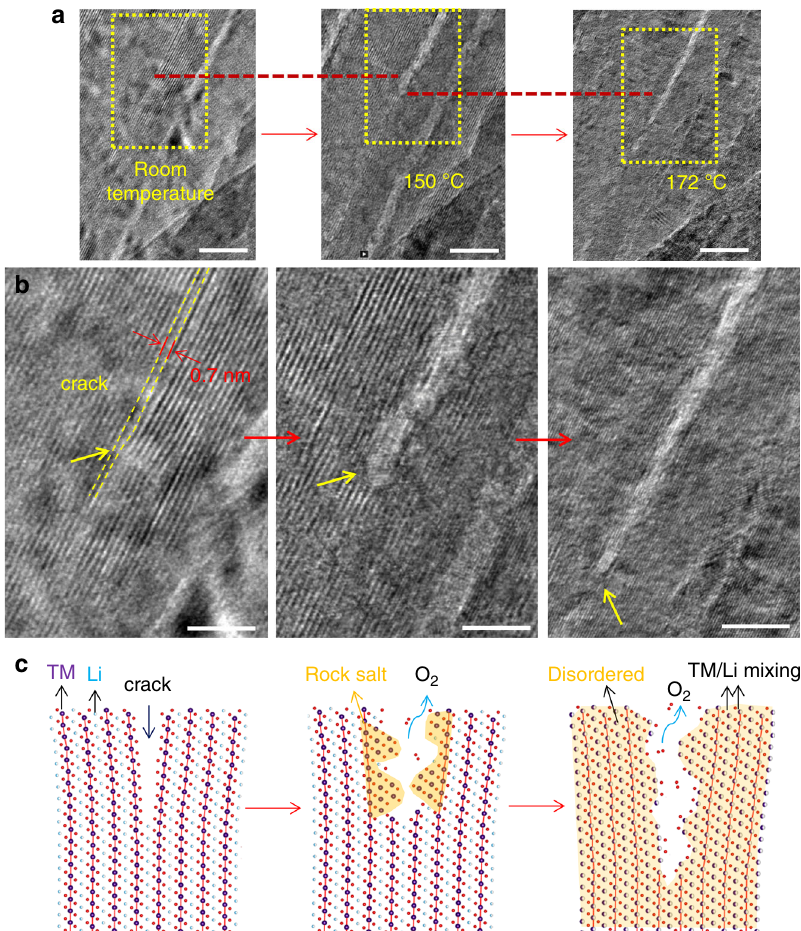
Fig. 4 In situ observing crack propagation with high-resolution transmission electron microscopy. a Low magni fi cation image series showing crack propagation during heating, where the dash-red lines mark the same location. b Lattice images taken from the regions marked by the dash-yellow rectangular in ( a ), showing the structure change, crack widening, and propagation during heating, where the yellow arrows indicate the crack tip. c Schematic illustration of the cracking process during heating. The red arrows indicate the progression of heating. The scale bars are 10 nm in ( a ) and 5 nm in ( b ). “ TM ” in ( c ) is the abbreviation of “ transition metal